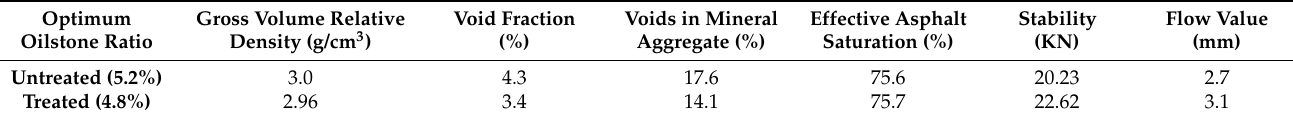
Table 6. Marshall test results of steel slag asphalt mixture at optimum asphalt